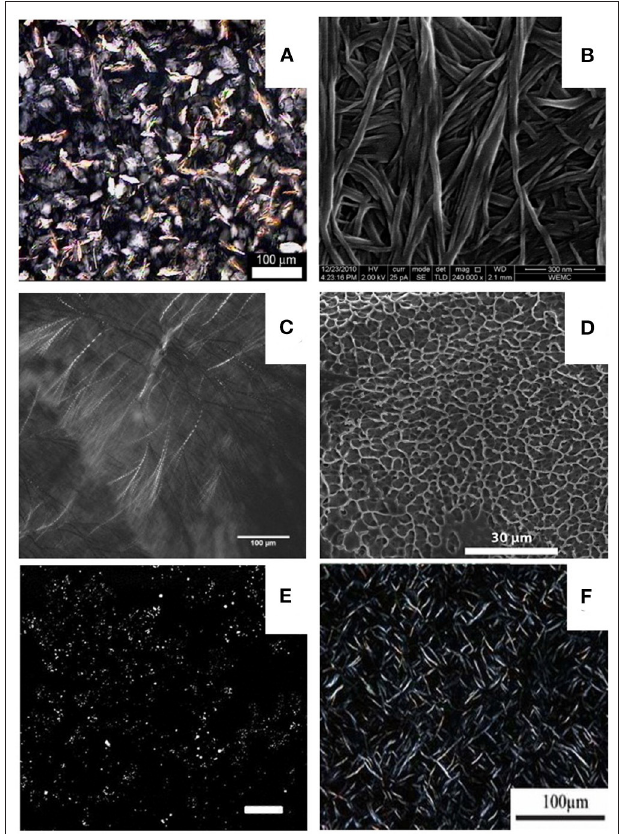
FIGURE 2 | Microstructures of oleogels structured with (A) monoglycerides in high oleic safflower oil (adopted from López-Martínez et al., 2014 with permission from Elsevier), (B) phytosterol tubules in sunflower oil (adopted from Sawalha et al., 2013 with permission from Wiley-VCH), (C) 12-hydroxystearic acid in canola oil (adopted from Co and Marangoni, 2013 with permission from Wiley-VCH), (D) ethylcellulose in canola oil (adopted from Zetzl et al., 2014 with permission from Elsevier), (E) candelilla wax in high oleic sunflower oil with a scale bar of 50 µ m (adopted from Patel et al., 2015 with permission from ACS Publications), and (F) sunflower wax in olive oil (adopted from Yilmaz and Ögütcü, 2014 with permission from Wiley-VCH).